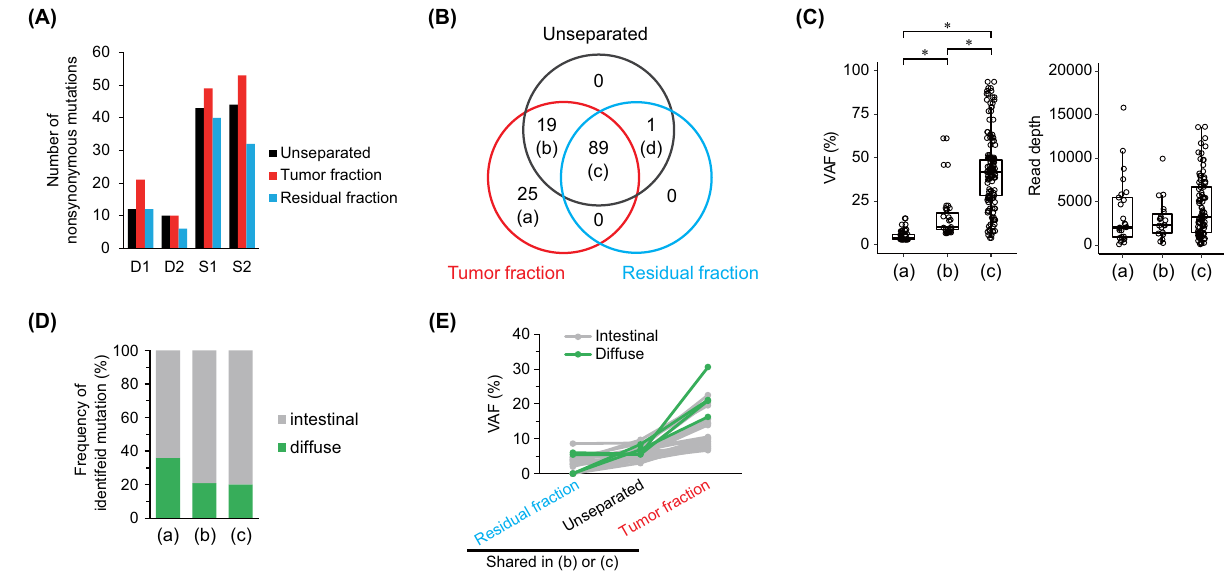
Figure 4. Influence of tumor cell enrichment on the detection of somatic mutations. ( A ) Comparison of nonsynonymous mutations between the separated and unseparated samples. ( B ) Venn diagram of nonsynonymous mutations detected in each separated fraction and unseparated sample. ( C ) Variant allele frequency (VAF) and read depth of somatic mutations. * p < 0.003 (Welch’s t-test with Bonferroni correction). ( D ) Frequency of somatic mutations detected in diffuse-type and intestinal gastric cancers. ( E ) Variations in the VAF in unseparated samples and tumor fractions. This variation represents mutations with less than 10% VAF in unseparated samples. Green and gray lines show variations of somatic mutations detected in diffuse-type and intestinal gastric cancers, respectively. The groups of (a), (b), and (c) correspond to the Venn diagram in ( B ). The mutation in (b) is defined as having a VAF value of 0 for the residual fraction.